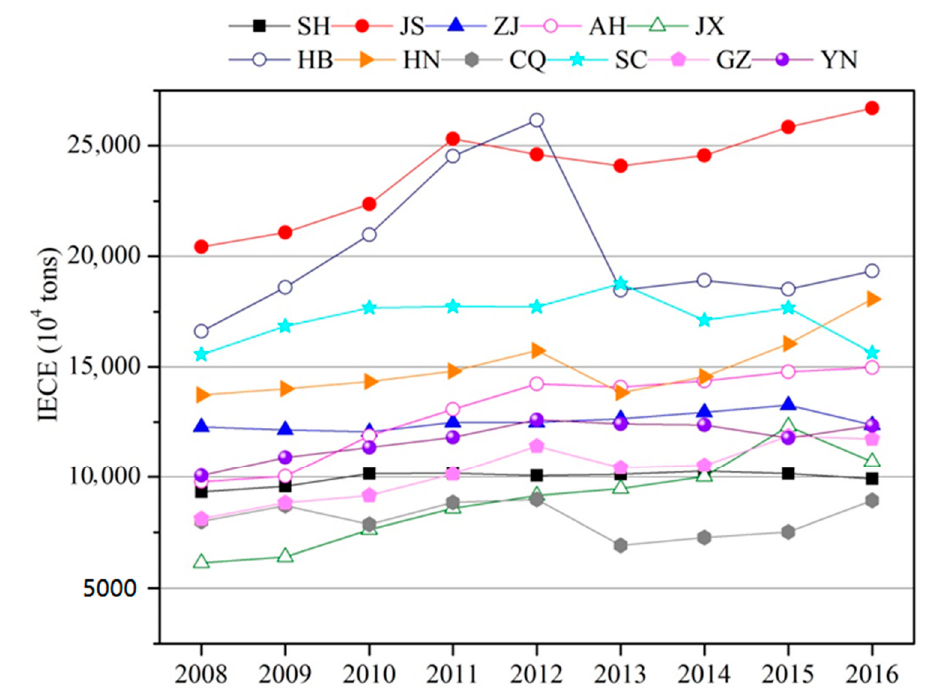
Figure 3. Spatial and temporal changes in IECEs in the YREZ during 2008–2016.